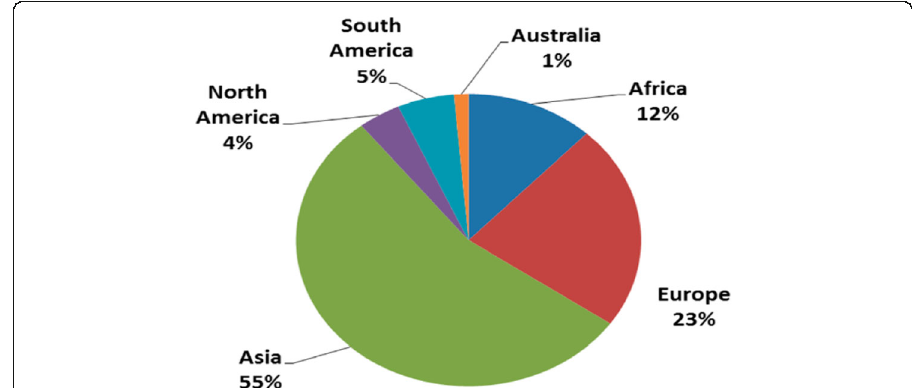
Fig. 6 Contribution percentage of different continents to the studies of the impact of dust on PV panels